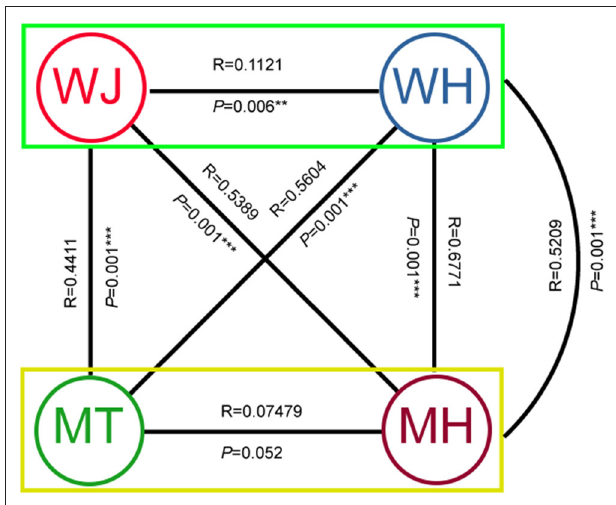
FIGURE 5 | Correlation between different sampling time periods. WJ, the jointing stage of the wheat season; WH, the harvesting stage of the wheat season; MT, the tasseling stage of the corn season; MH, the maturity stage of the corn